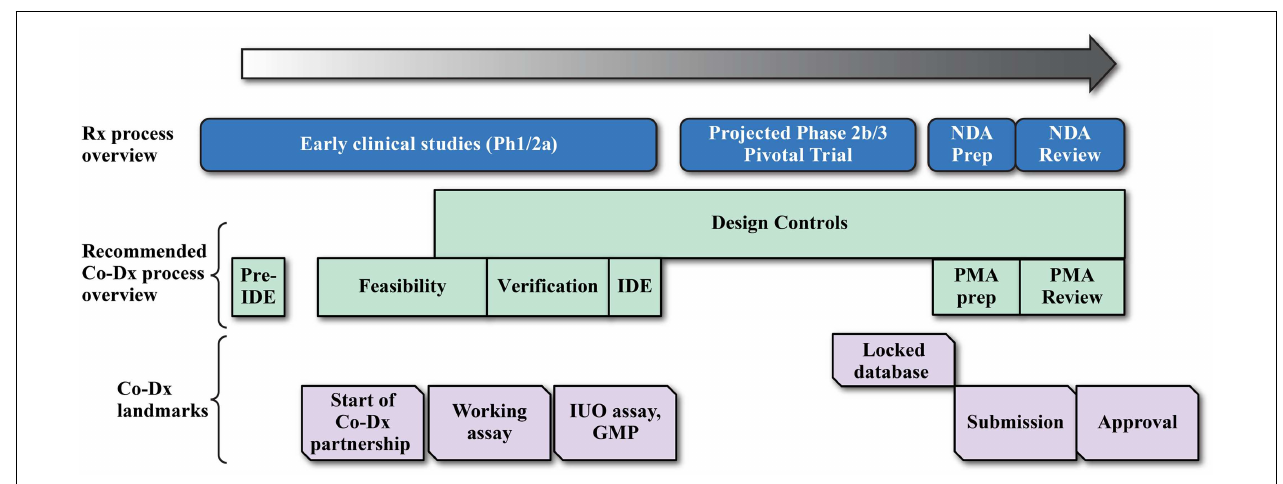
FIGURE 4 | Coordination of drug and device development for a successful companion diagnostic submission . Drug companies and diagnostic developers may work together in several different cost sharing and assay development landmark payment formats for the development of the final IVD product.